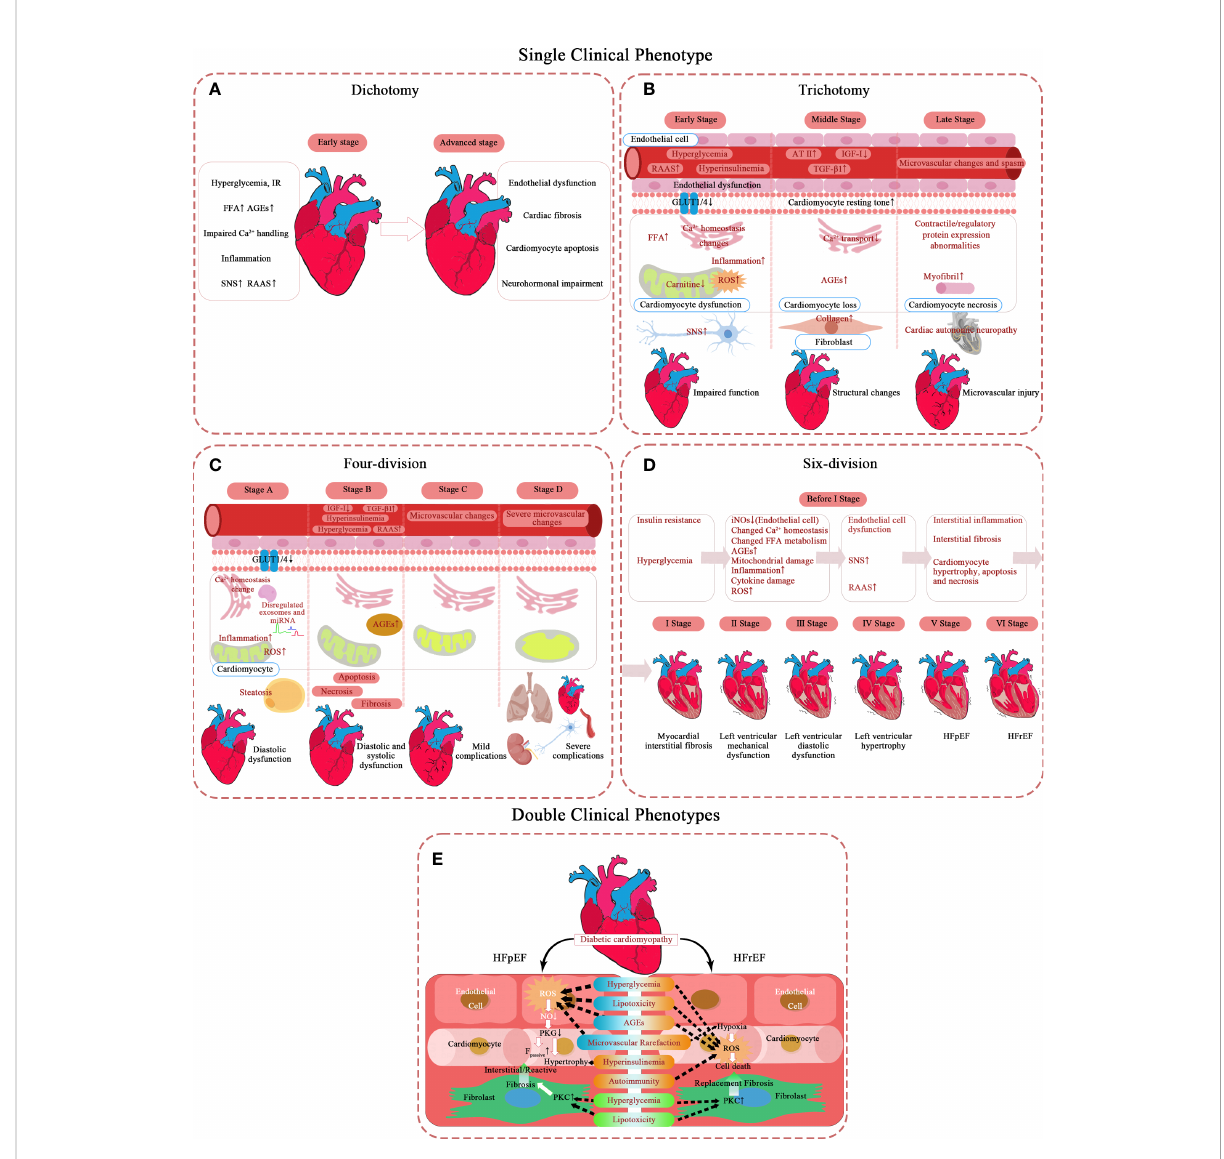
FIGURE 1 Pathological mechanism of DCM in different types of phases of progression. (A – D) Single clinical phenotype. (E) Double clinical phenotypes. AT-II, angiotensin II; AGEs, advanced glycation end-products; F passive , cardiomyocyte resting tension; FFA, free fatty acid; GLUT1, glucose transporter 1; GLUT4, glucose transporter 4; HFrEF, heart failure with reduced ejection fraction; HFpEF, heart failure with preserved ejection fraction; IR, insulin resistance; IGF-I, insulin-like growth factor 1; NO, nitric oxide; PKC, protein kinase C; PKG, protein kinase G; RAAS, renin- angiotensin-aldosterone system; ROS, reactive oxygen species; SNS, sympathetic nervous system; TGF- b 1, transforming growth factor b